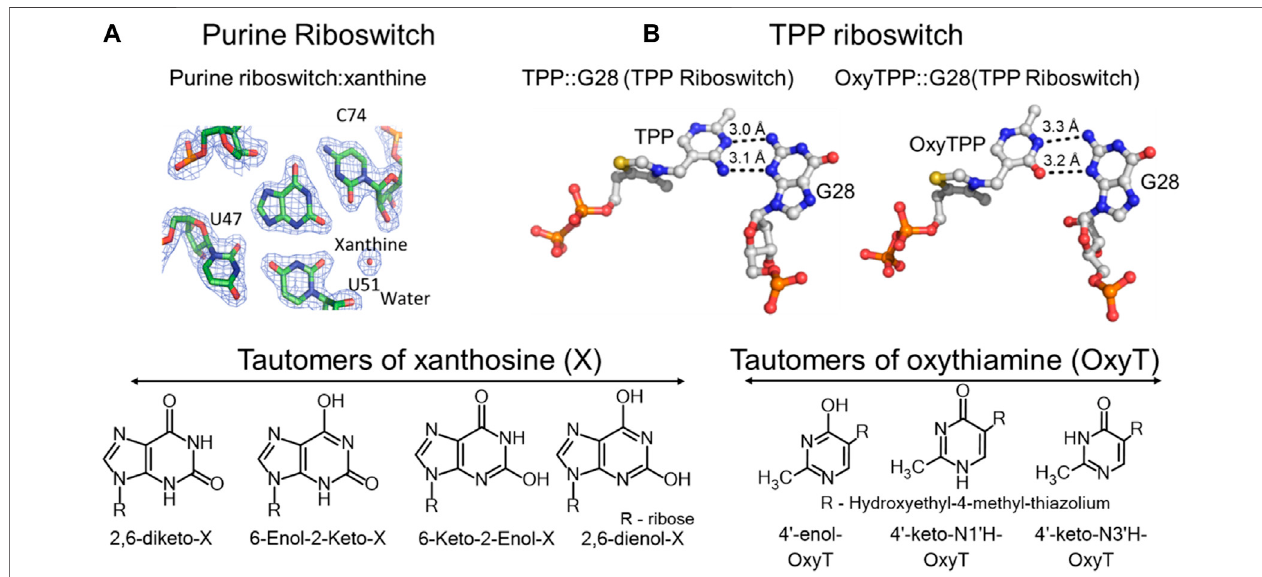
FIGURE2| Tautomerisminriboswitches. (A) Topleft,crystalstructureofthepurineriboswitchwithxanthineinitsbindingpocketinteractingwithcarbonyloxygens ofC74,U47andU51,andawatermolecule.Bottomleft,allpossibletautomericformsofxanthosine. (B) CrystalstructuresoftheTPPriboswitchshowinginteractionsof itsbindingsiteG28(guanosineatthe28thposition)withthethiaminepyrophosphate(TPP)andoxythiaminepyrophosphate(OxyTPP)ligands.Bottom,tautomericforms of oxythiamine identi fi ed by NMR and vibrational spectroscopy (Singh et al., 2014). The fi gure is adapted from reference (Singh et al., 2014) (CC BY 4.0).